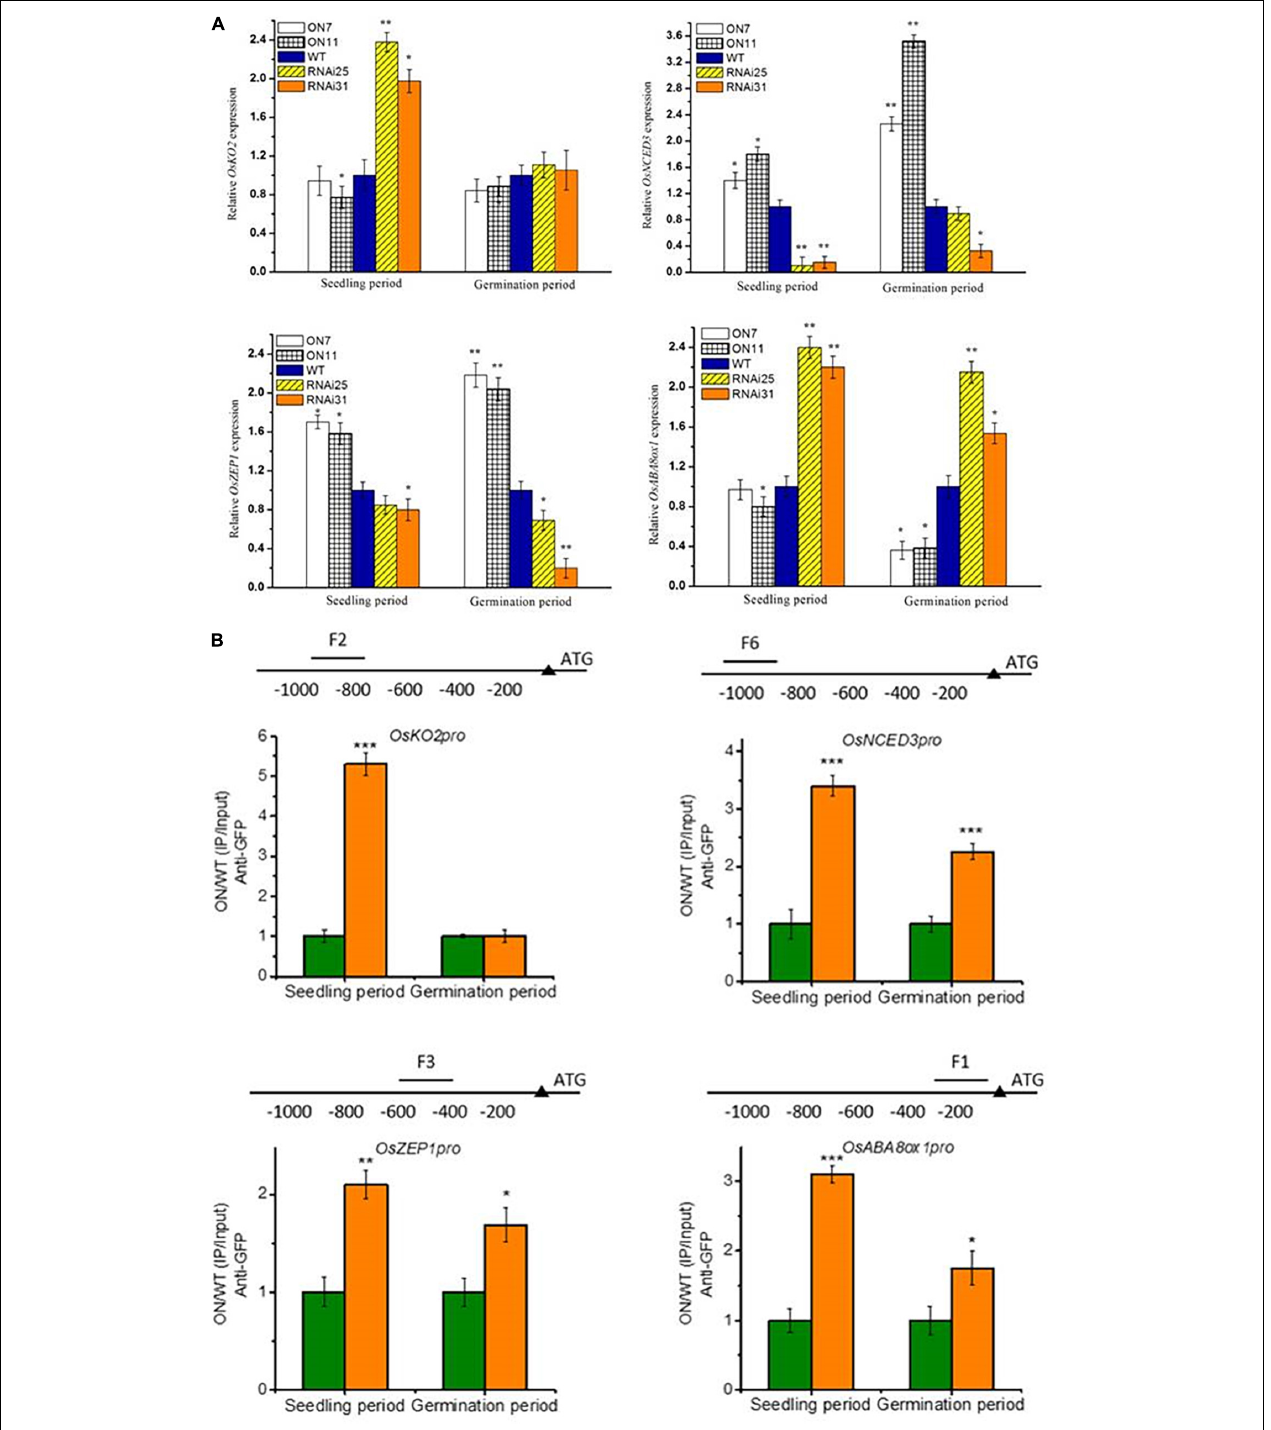
FIGURE 5 | The otherness of OsNAC2 in regulating multiple downstream targets. (A) Expressions of abscisic acid (ABA) biosynthetic ( OsNCED3 and OsZEP1 ) and catabolic genes ( OsABA8ox1 ) and gibberellic acid (GA) biosynthetic genes ( OsKO2 ) in OsNAC2 -transgenic seeds and seedlings. (B) Chromatin immunoprecipitation–quantitative polymerase chain reaction (ChIP–qPCR) assays of OsNAC2 on the promoters of OsABA8ox1 , OsNCED3 , OsZEP1, and OsKO2 . Total protein extracted from 35S:OsNAC2-mGFP transgenic seeds were immunoprecipitated with an anti–green fluorescent protein (GFP) antibody. Fragmented genomic DNA was eluted from the protein–DNA complexes and subjected to the qPCR analysis. The long black bars represent promoter regions for which we designed primers. The numbers under the bar show the distance from the ATG start codon. Short bars represent the corresponding region of each pair of primers on the promoter. Error bars represent the standard error of three biological replicates. * p < 0.05, ** p < 0.01, and * p < 0.001.